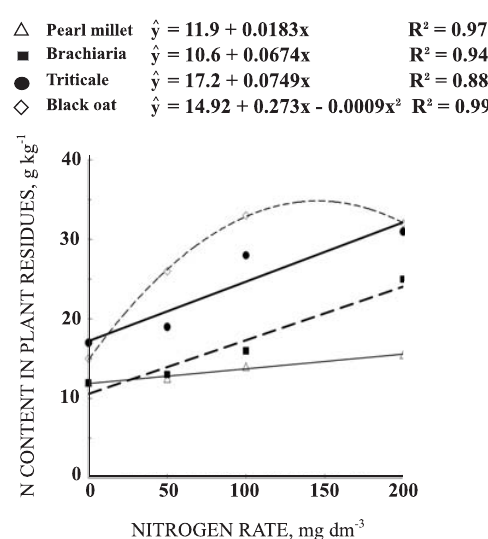
fertilizationFigure 2. Nitrogen level in shoot dry matter of different cover grasses, as related to N fertilization, 54 days after sowing. Vertical bar show the LSD comparing species (p ≥≥≥≥≥ 0.05). ** R 2 significant (p ≤≤≤≤≤ 0.001); ns R 2 non